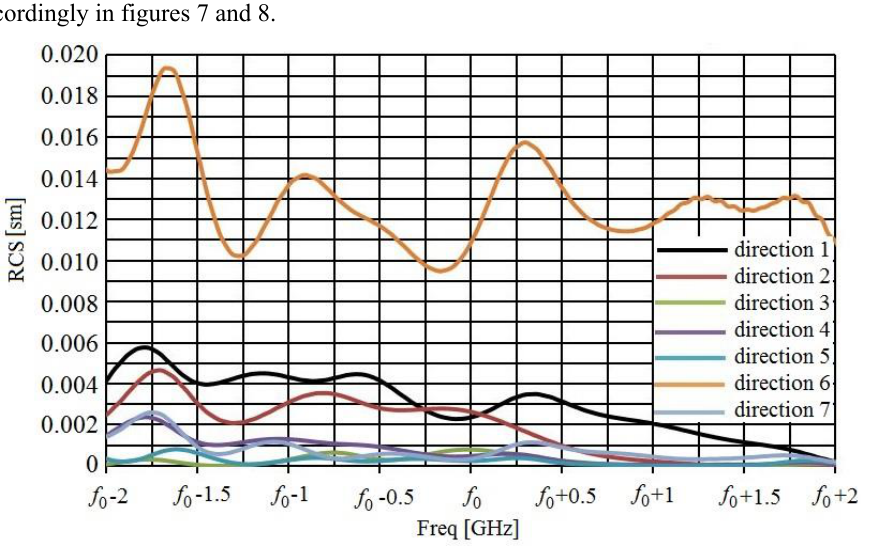
Fig. 7. The RCS of quadrocopter Syma X12 in K a -band at the horizontal polarization.